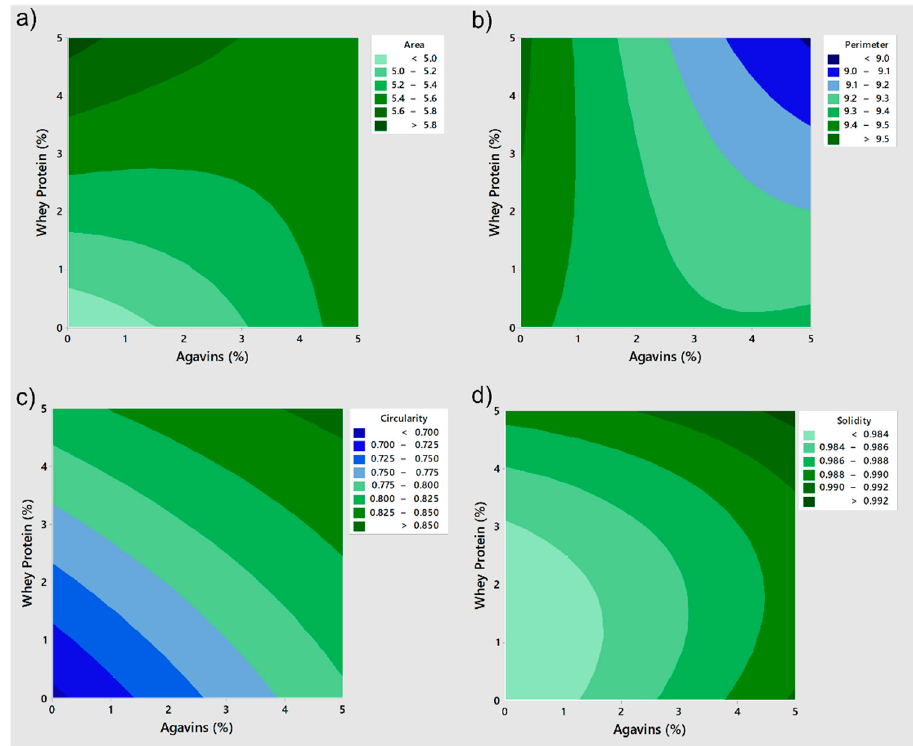
Figure 1. Contour plots: ( a ) Area vs. whey protein, agavins; ( b ) Perimeter vs. whey protein, agavins; ( c ) Circularity vs. whey protein, agavins; ( d ) Solidity vs. whey protein, agavins, obtained from a response surface analysis for each of the different types of beads with S. boulardii .